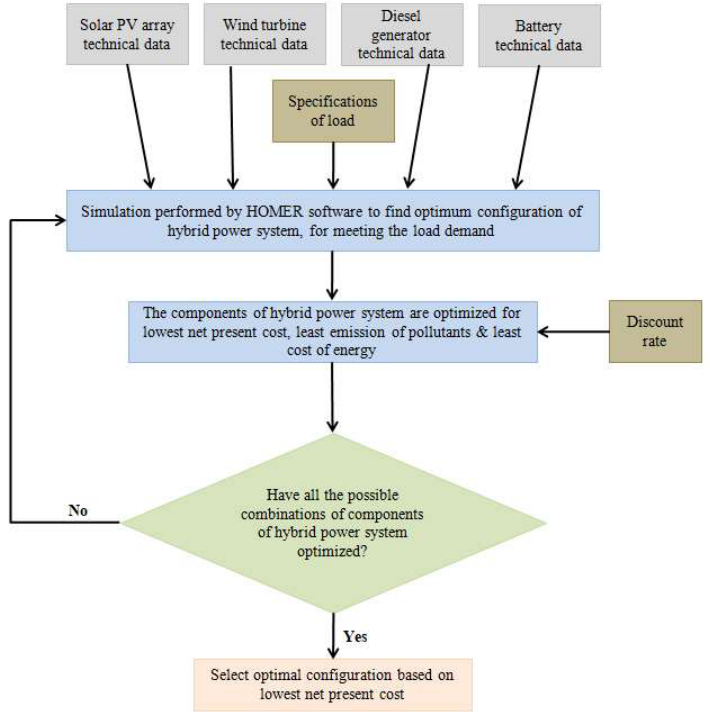
Figure A1. Flow chart of algorithm used by HOMER.